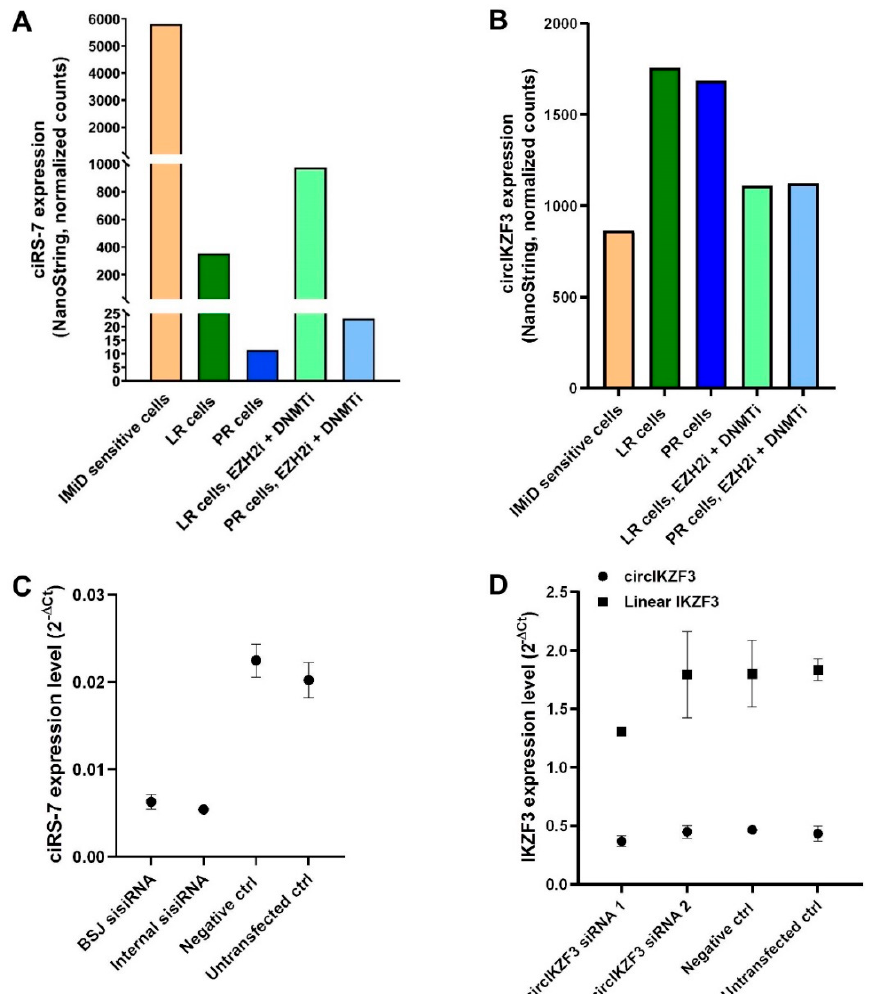
Figure 4. Validation of circRNA candidates from the RNA-Seq data by NanoString nCounter technol- ogy ( A , B ) ciRS-7 expression ( A ) and circIKZF3 expression ( B ) (analyzed by NanoString nCounter technology) in IMiD-sensitive, LR cells, PR cells, LR cells treated with EZH2i and DNMTi, and PR cells treated with EZH2i and DNMTi. ( C ) Expression of ciRS-7 five days post sisiRNA transfection. Relative expression of ciRS-7 (analyzed by reverse transcriptase-quantitative PCR (RT-qPCR)) in cells transfected with two different sisiRNAs targeting ciRS-7 (denoted as BSJ and Internal). Error bars reflect technical triplicates. ( D ) Expression of circIKZF3 five days post siRNA transfection. Relative expression of circIKZF3 (analyzed by RT-qPCR) in cells transfected with two different siRNAs target- ing the back-splice junction of circIKZF3. Error bars reflect technical triplicates. BSJ: back-splicing junction, LR, lenalidomide-resistant, PR,